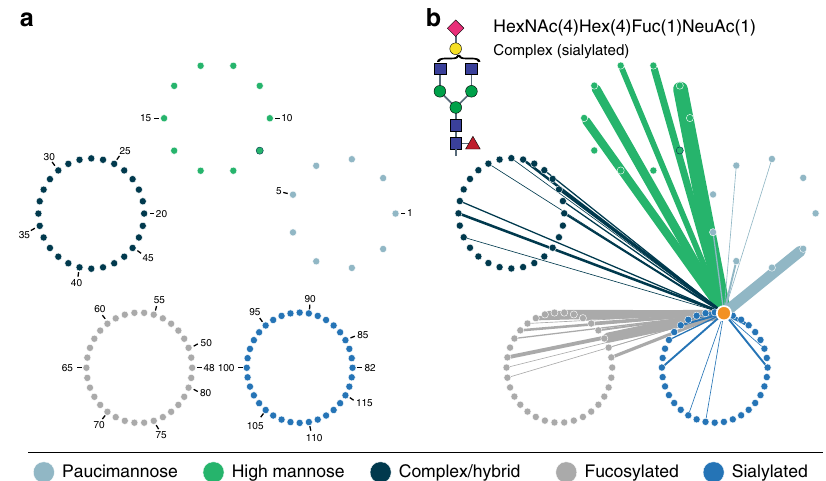
Fig. 3 Glycan co-occurrence networks. a The organization of the glycan co-occurrence network is given, where glycans are sorted into circles based on glycan type, each node is one of the 117 glycans identi fi ed, and the numbers indicate glycans identities given in Supplementary Table 3. Glycan 19 (green with dark blue border) indicates mannose-6-phosphate. b The glycan co-occurrence network shows all the glycans that co-occurred with HexNAc(4)Hex (4)Fuc(1)NeuAc(1) (highlighted as an orange node, i.e., the source node), with the relative number of occurrences indicated by edge thickness. Edge color indicates the target